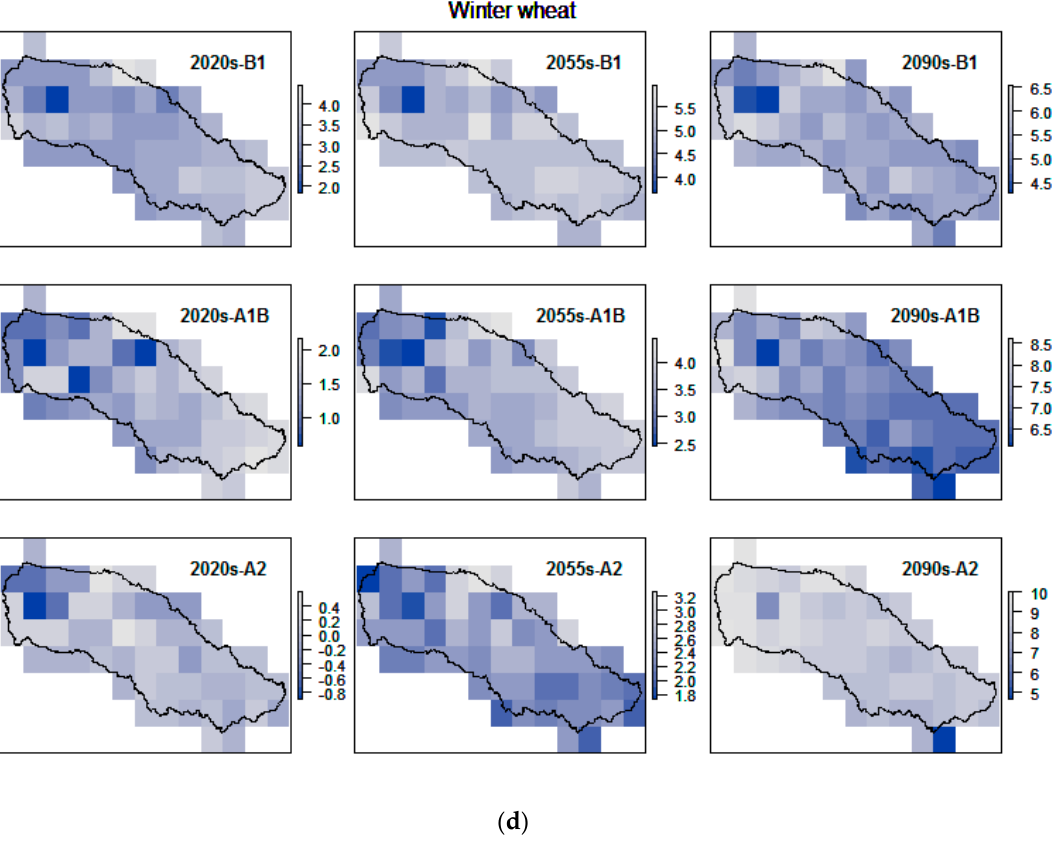
Figure 6. Spatial changes (in percentage) of irrigation requirement of corn ( a ); cotton ( b ); sorghum ( c ); and winter wheat ( d ) for three future periods (2020s, 2055s, and 2090s) and under three greenhouse emission scenarios compared with the baseline period.